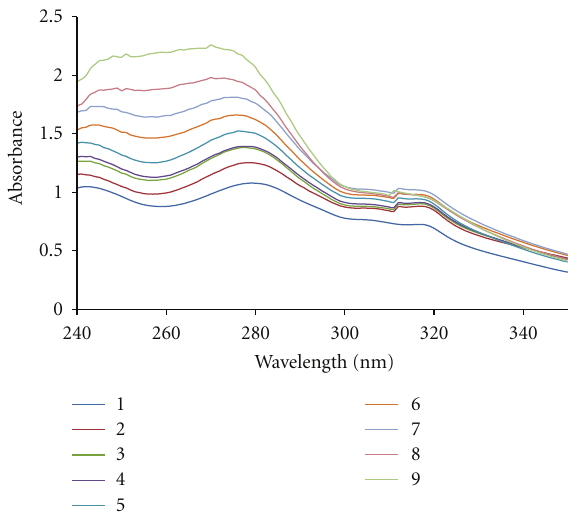
Figure 2: Absorption spectra of DNA (5 × 10 − 5 M) in the absence and in the presence of increasing amounts of platinum complex (ri =